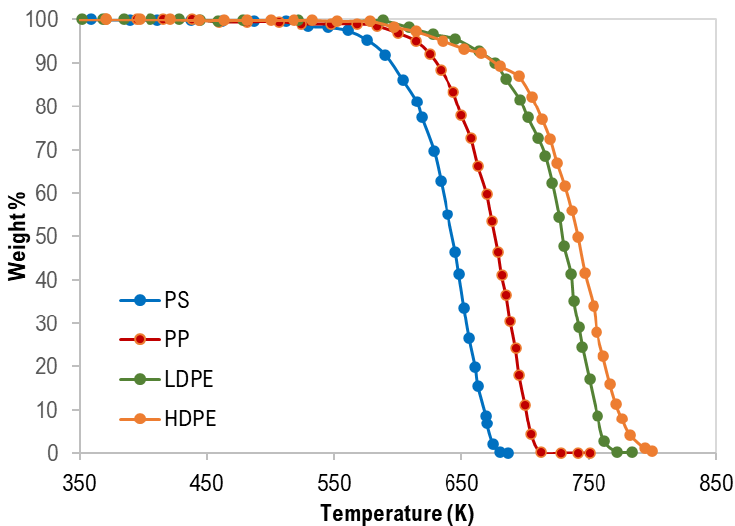
Figure 1. Thermogravimetric (TG) curves of pure polymer samples.